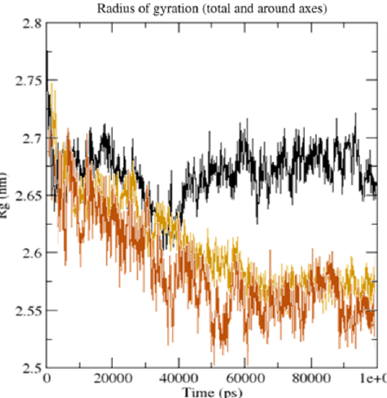
Figure 12. The RR distance map displaying patterns of spatial interactions between ( a ) the unbound serotonin receptor and the serotonin receptor after the simulation for GpnS ; and ( b ) the unbound serotonin receptor and serotonin receptor after simulation for CuGS , showing the average distance and standard deviation for all amino acid pairs. (MDS = Molecular Dynamics simulation).